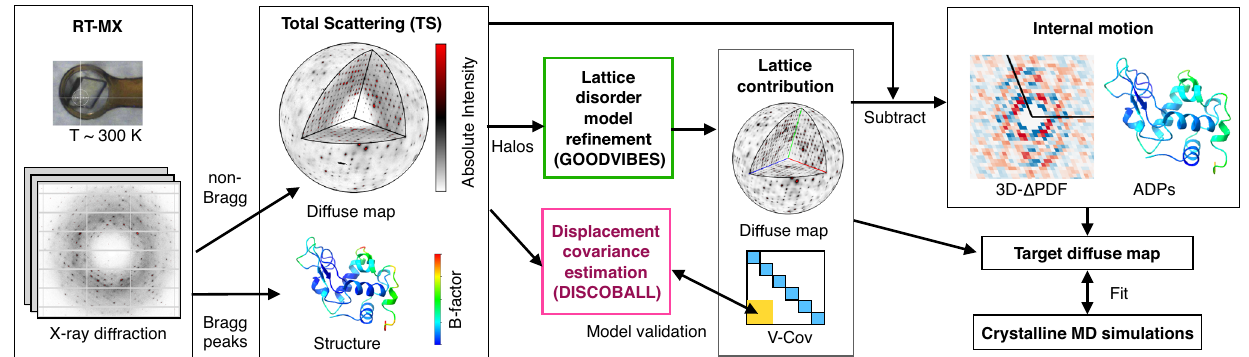
Fig. 1 | Work fl ow to measure and interpret protein correlated motion using X-ray crystallography. First, X-ray diffraction images are acquired from protein crystals at room temperature(RT-MX).The Bragg peaksand continuous scattering are processed separately to obtain the protein structure and a three-dimensional map of diffuse scattering on an absolute intensity scale (electron units). The structure includes mean atomic positions and atomic displacement parameters (ADPs or B-factors) that quantify motion, and the pattern of diffuse scattering depends on how motions are correlated. To separate the internal and external (rigid-body) protein motions, a physical model of lattice disorder is re fi ned to the intense diffuse halo features (GOODVIBES), and the lattice contribution to the